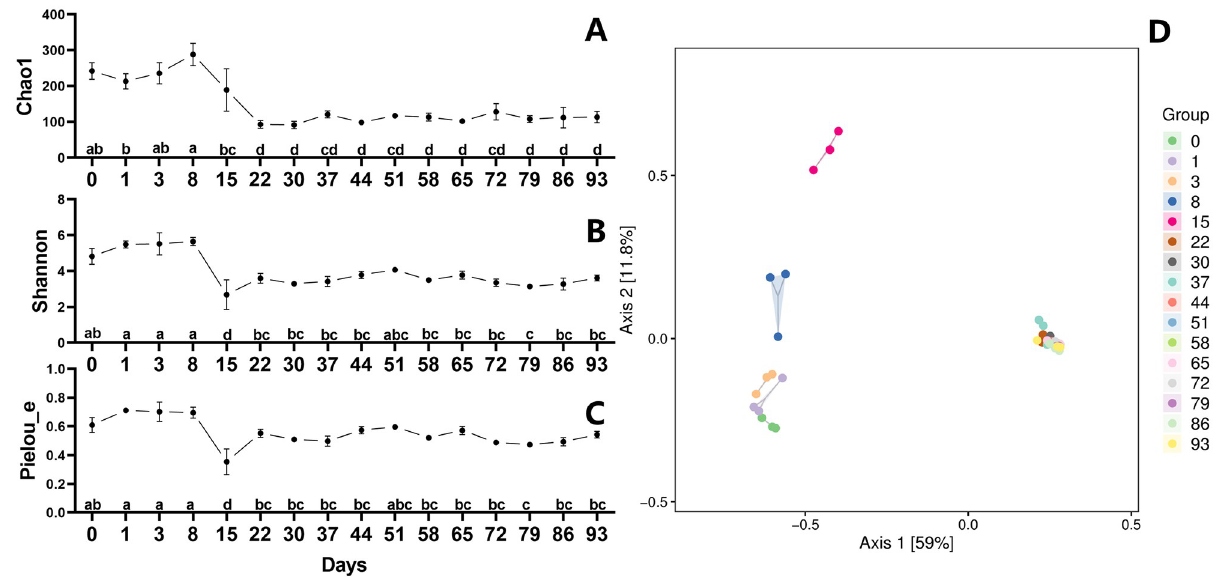
Fig 6. Changes in fungal alpha and beta diversity during fermentation. Chao1 (A), Shannon (B), Pielou_e (C), and Principal coordinate analysis (PCoA) (D) were assessed during the EFS process. Statistical assessment was carried out with one-way ANOVA followed by post hoc test using Dunn’s multiple comparison test. Values with different letters are significantly different at P <